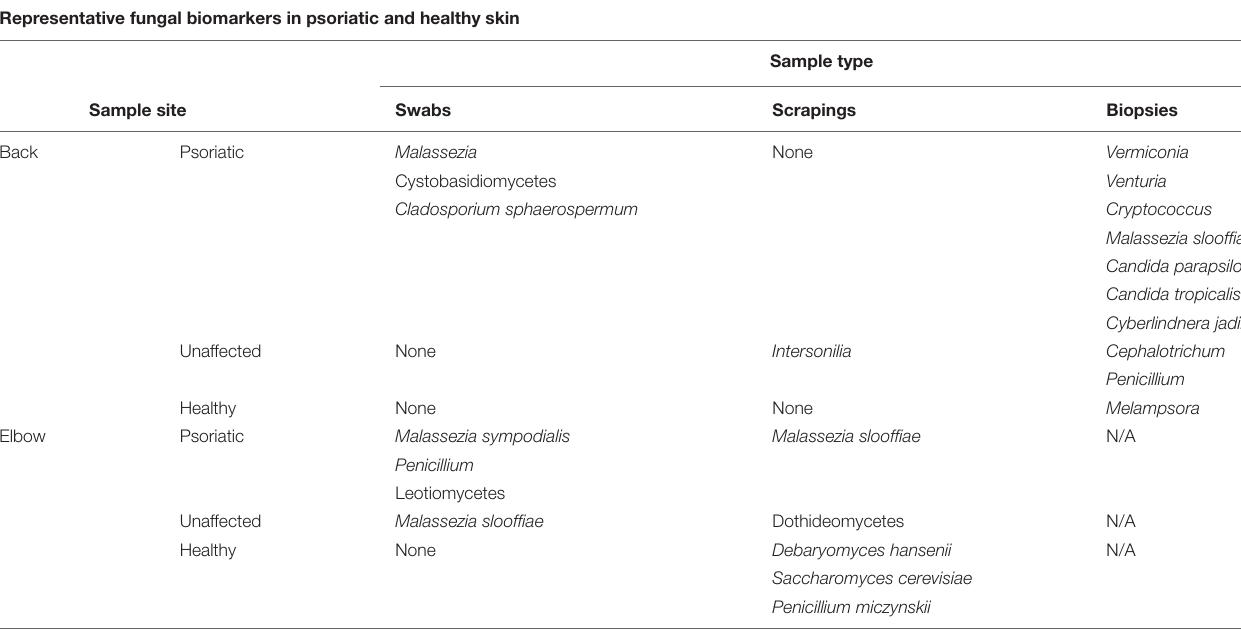
FIGURE 2 | Analysis of bacterial communities isolated from swabs using the V3V4 region of the 16S rRNA gene. LEfSe analysis revealed microbial patterns that are significantly differentially abundant in back (A) or elbow (B) samples. Predicted functional profiles of metabolic pathways in back (C) or elbow (D) samples associated with psoriatic, unaffected or healthy control skin. Heat maps include only KEGG pathways with abundance above 1% for each site and disease status. The differences are color-coded by the relative abundance of the metabolic pathway. Red: high abundance; blue: low abundance. Discriminative metabolic pathways in back (E) or elbow (F) samples revealed by LEfSe analysis. Disease status: Ps, psoriatic; Un, unaffected; He, healthy skin. TABLE 2 | The main discriminative fungal features related to the sampling